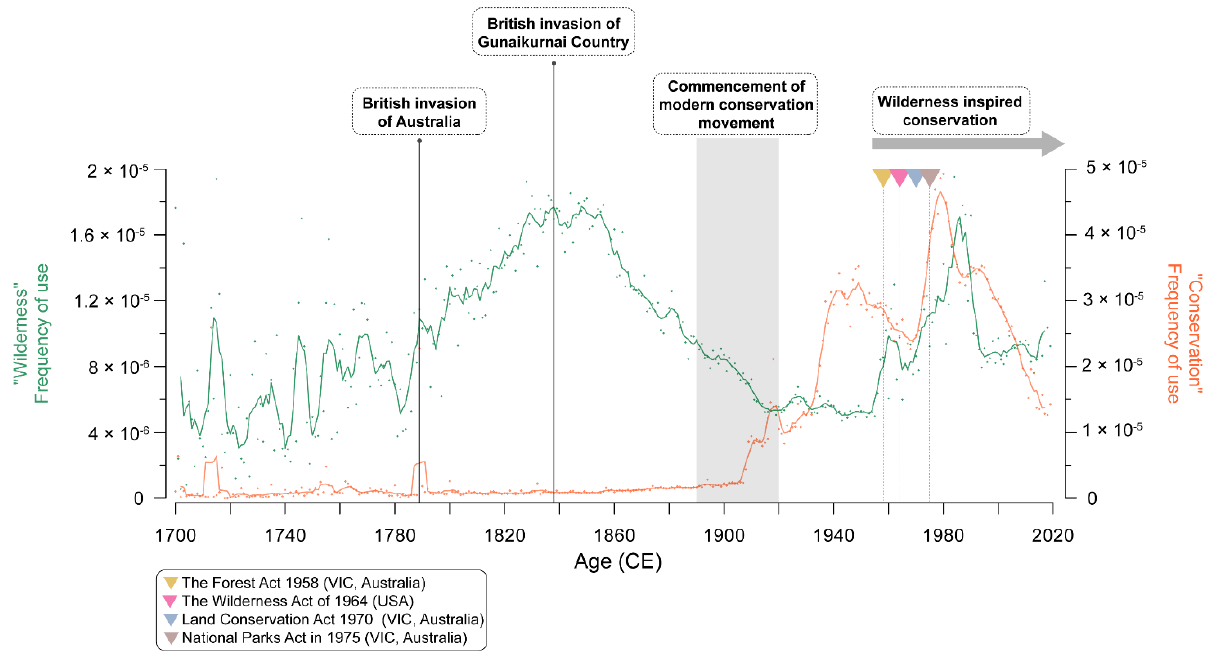
Figure 2. The frequency of the use of the terms ‘wilderness’ (green) fit with a weighted average (window width = 5) (solid green line) and ‘conservation’ (orange) fit with a weighted average (window width = 5) (solid orange line) from 1700–2019. Data derived from Google Books Ngram Viewer using ngramr in R [82]. This study searched the terms (ngrams) ‘wilderness’ and ‘conservation’ (not case sensitive) in books published between 1700 and 2019 within the digitised ‘English 2019’ (eng_2019) corpus (all books in the English language published in any country available on Google). The 2019 corpus is the most up to date with more books, improved tokenisation, optical character recognition (OCR) and library/publisher metadata. Ngrams were searched when they also crossed page boundaries but not across sentence boundaries. For interpretation of the references to colour in this figure legend, the reader is referred to the web version of this article.